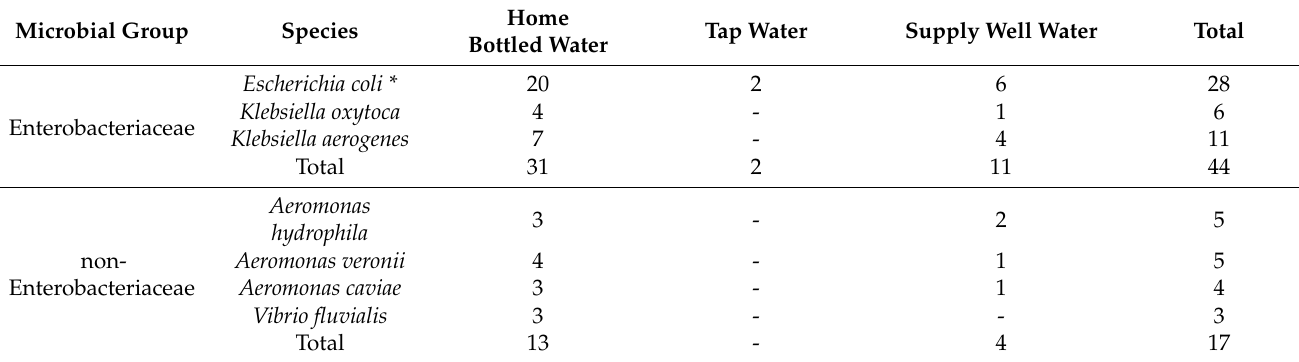
Table 2. Source, number, and identification of selected isolates by 16S rRNA gene sequencing.